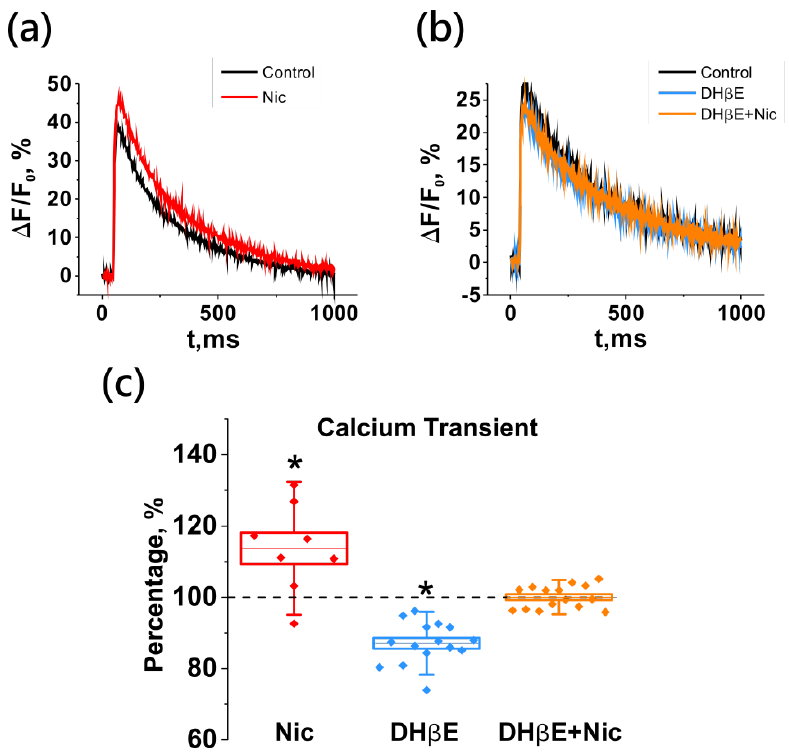
Figure 4. Nicotine increases the calcium transient in the motor nerve ending by the activation of neuronal ACh receptors. Blockade of the receptors leads to a decrease in the amplitude of the calcium signal. Panels on the top are representative traces of calcium transient from separate experiments with nicotine application (Nic, 10 µM; ( a )), and nicotine application after pretreatment with an nNAChR antagonist DHβE (1 μM; ( b )). ( c ) Mean ± SEM and SD of the amplitude of the calcium signal, expressed as a percentage of control when applying nicotine ( n = 8), DHβE ( n = 15) and DHβE plus nicotine ( n = 15). Asterisks (*) indicate significant effects ( p < 0.05, one-way repeated ANOVA test with Tukey’s post-hoc comparison).